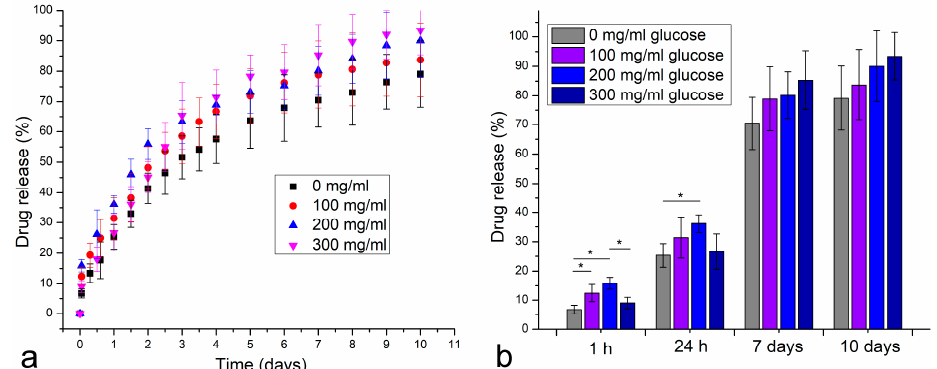
Figure 3 Figure 3. Comparative insulin proxy release profiles for PCL and MnO and with ( b ) 100 mg/mL glucose in the medium. Data points are shown as averages (n = 3), while error bars represent standard deviations.